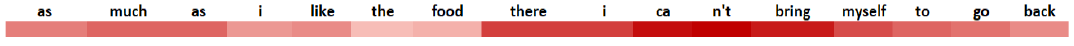
Figure 5. Attention weights where food is the aspect word.